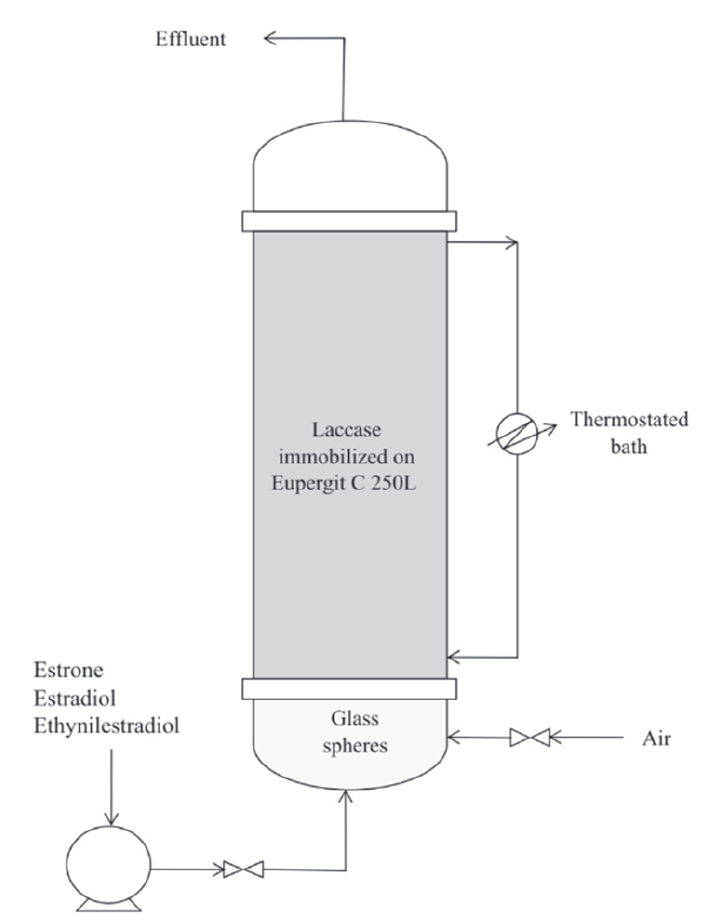
Figure 9. Diagram of fluidized-bed reactor with laccase enzyme immobilized on Eupergit C Reprinted from [168] with permission from Elsevier. Copyright © 2021 Elsevier B.V. License Number: 5174590199379.